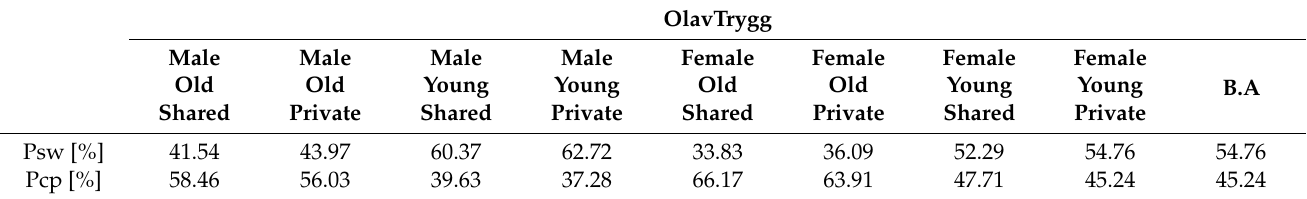
Table 11. Probability to choose the cycle path (Pcp) and sidewalk (Psw) for case 2.